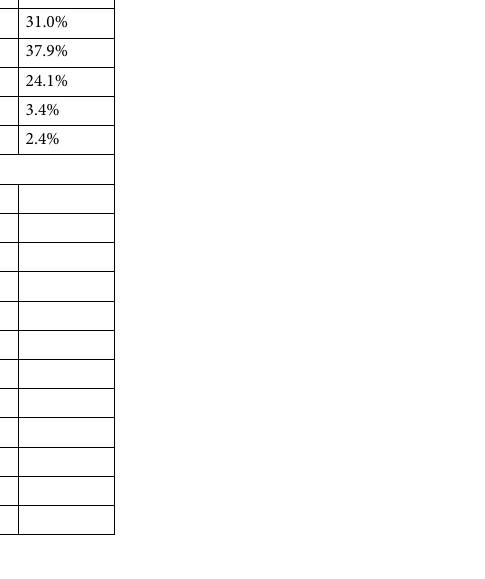
Table 1. Baseline